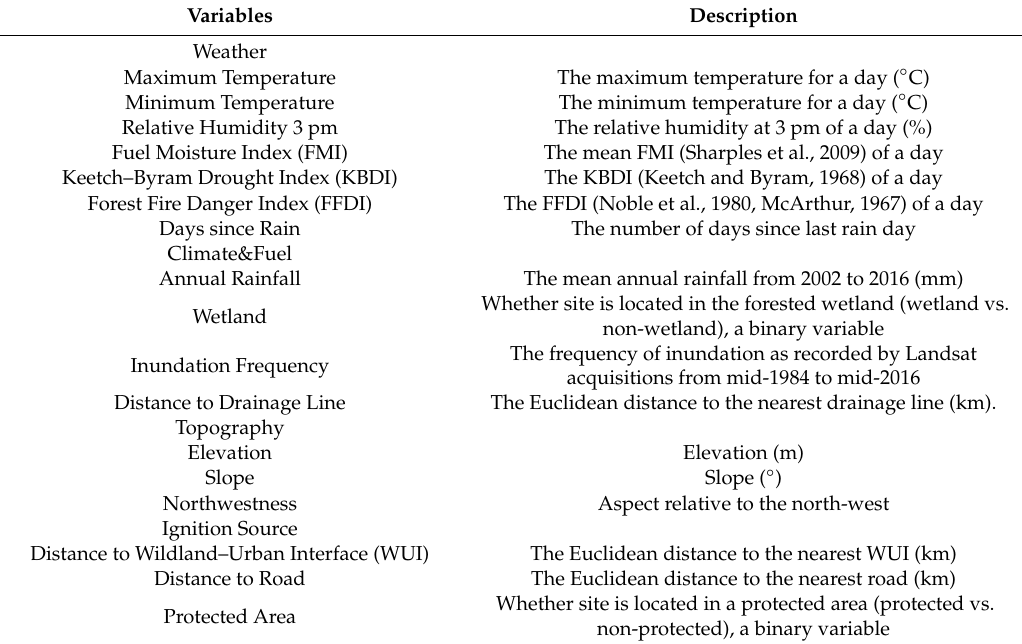
Table 1. Variables analysed in order to explain drivers of wildfire occurrence in the semi-arid inland riverine